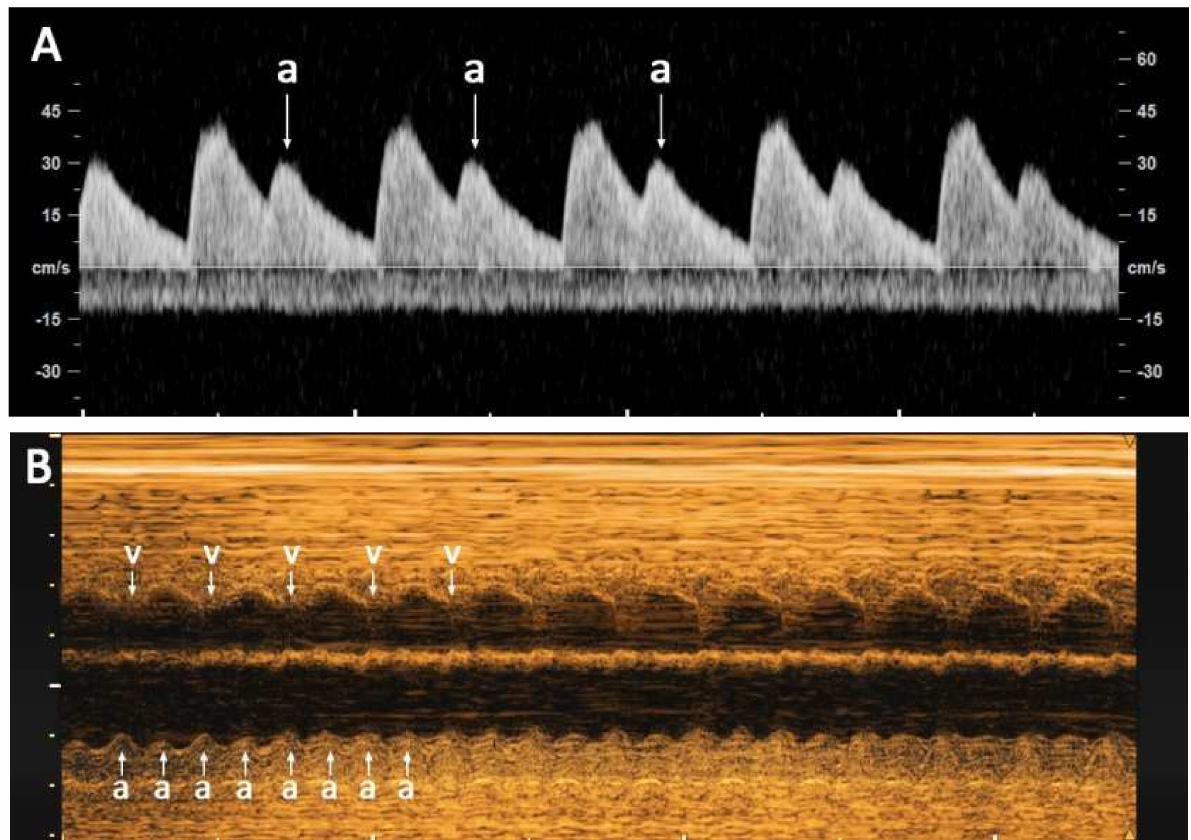
Figure 2. ( A ) Umbilical artery waveforms show premature atrial contraction/bigeminy (a): ( B ) M- mode shows atrial flutter; atrial rate (a): ventricular rate (v)